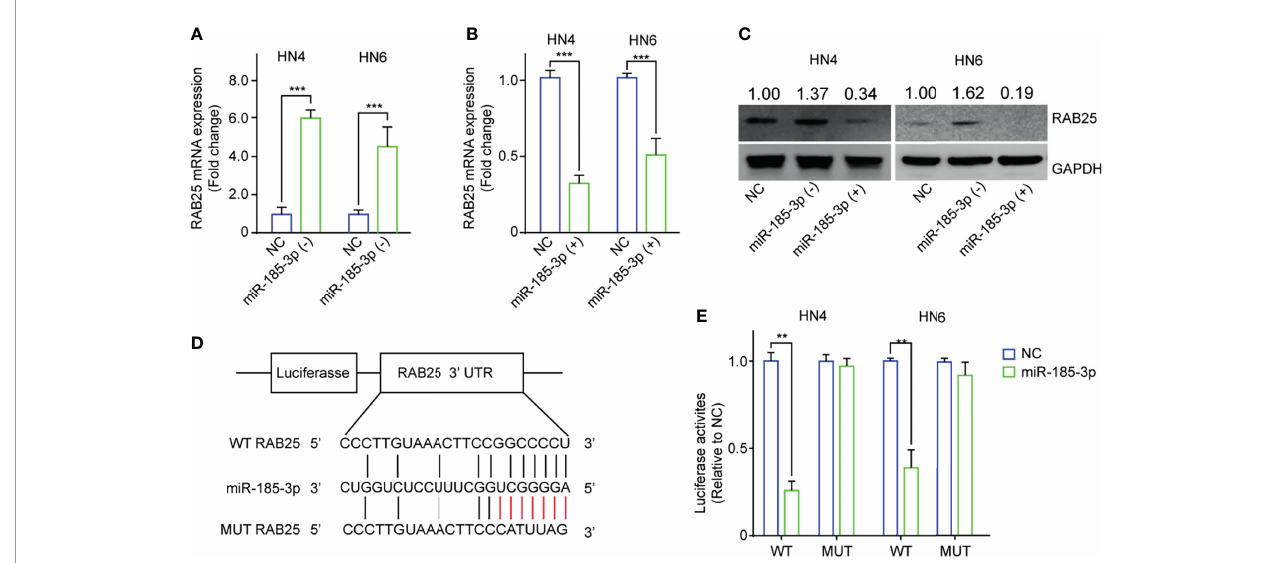
FIGURE 3 | RAB25 is a direct target of miR-185-3p. (A) The mRNA expression of RAB25 in HN4 and HN6 cells with miR-185-3p knockdown. (B) The mRNA expression of RAB25 in HN4 and HN6 cells with miR-185-3p overexpression. (C) The expression of RAB25 protein in HN4 and HN6 cells with miR-185-3p knockdown or miR-185-3p overexpression. (D) graphic illustration showing the miR-185-3p binding site of RAB25 3 ’ UTR as well as the mutate site. (E) Luciferase activity in HN4 and HN6 cells with WT or mutated miR-185-3p binding site. All experiments were replicated in triplicate. ** p < 0.01, *** p <